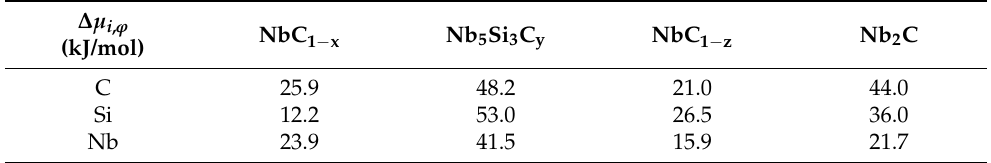
Table 7. Variation of the chemical potential gradient of C, Si and Nb through each reactive layer phase formed at the SiC/Nb interface at 1200 ◦